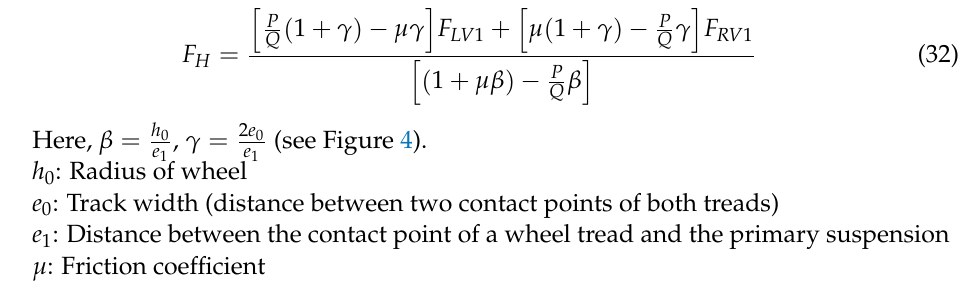
Table 11. The ratios of wheel unloading ( ∆ Q/Q) between the theoretical formula and the simulation for cross-wind along with dynamic wheel–rail interactions (P/Q = 0.315). Ratios of Wind Speeds Wheel Unloading Differences Track Condition [m/s] Theory Simulation 0 0.198 0.173 0.025 30 0.318 0.304 Straight track